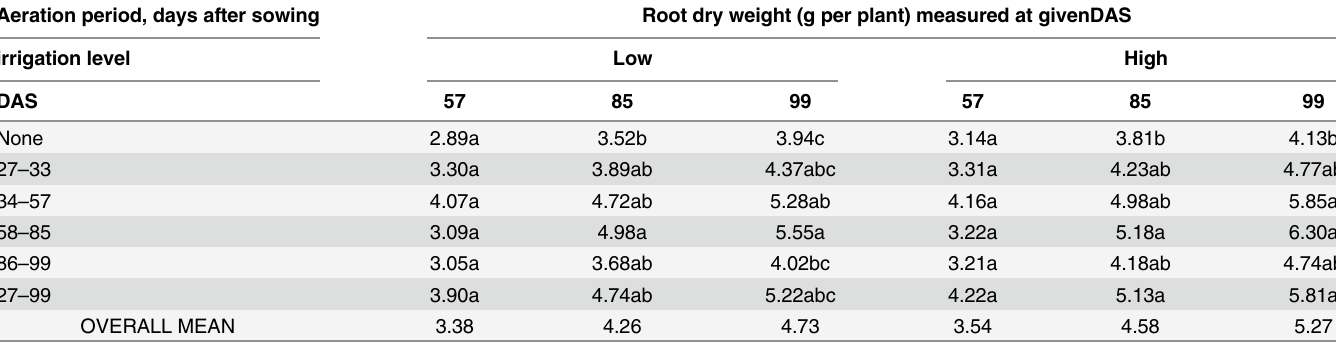
Table 2. Root dry weight (g per plant) of potted single tomato plants (n = 3) measured at 57, 85, and 99 days after sowing (DAS) for the 6 post-infil- tration aeration treatments (i.e. none or 2.5 liter aeration applied during 5 different periods) at the low and high irrigation levels (i.e. subsurface drip-irrigation to maintain soil at 60 to 70% and 70 to 80% of volumetric field capacity). Aeration period, days after sowing